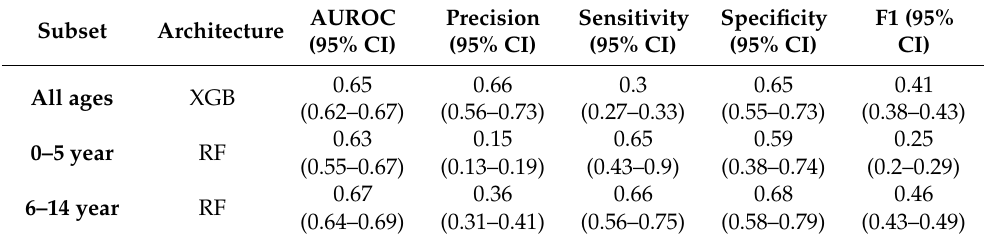
Table 4. Test scores for each of the fine-tuned best performing models with 95% CI.